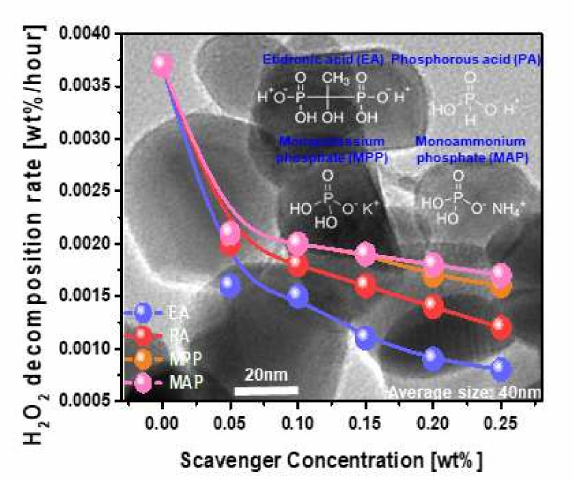
Figure 1. Dependency of the H 2 O 2 decomposition rate on the scavenger type and